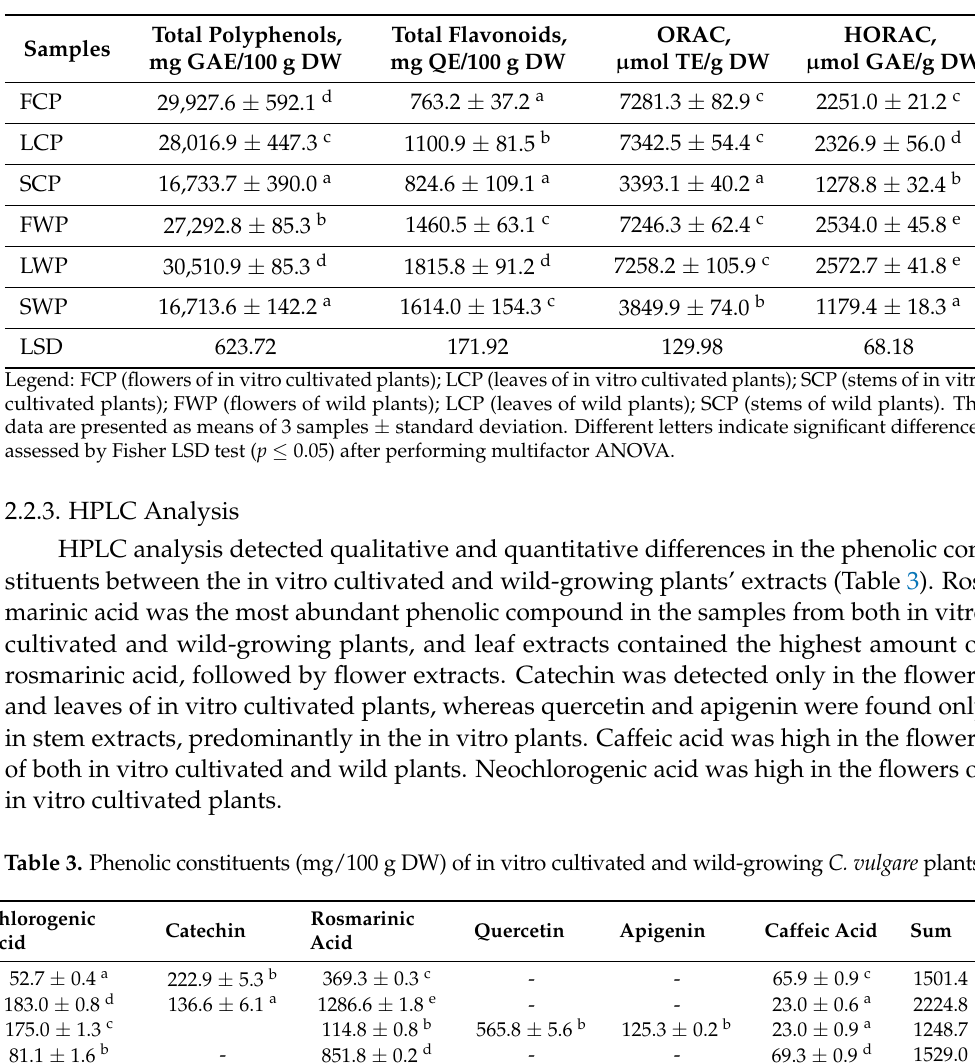
Table 2. Total polyphenol and flavonoid contents and antioxidant activity of freeze-dried aqueous extracts from different anatomical parts of in vitro cultivated and wild-growing C. vulgare plants.